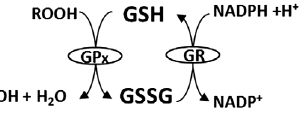
Figure 1: Glutathione cycle: a ROS scavenging pathway in Saccha- romyces cerevisiae .